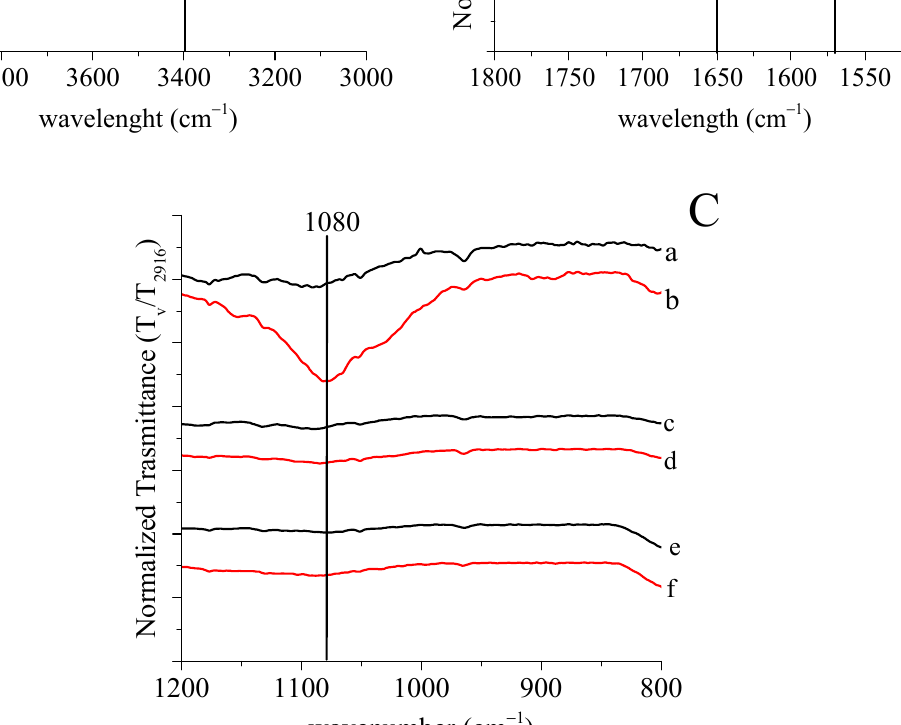
Before Grafting After